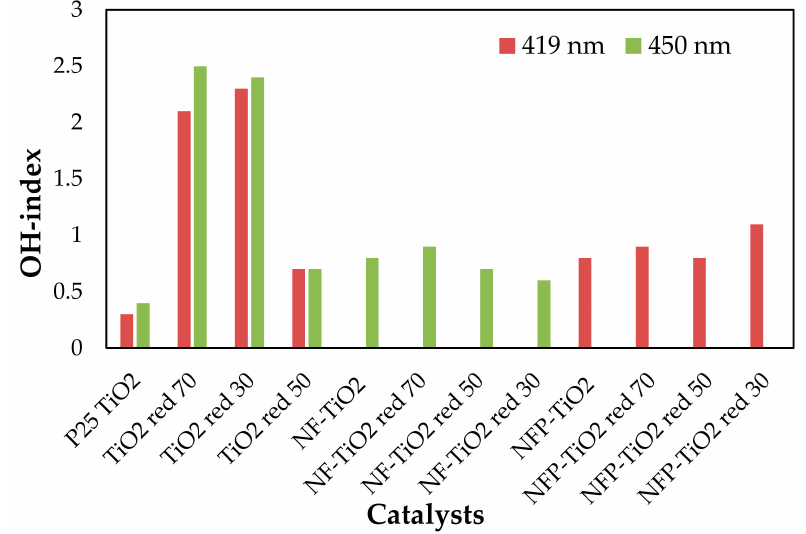
Figure 9. Relative comparison of OH-index of various TiO 2 -based photocatalysts at visible light (the data are reproducible with 5% of error based on some triplicate